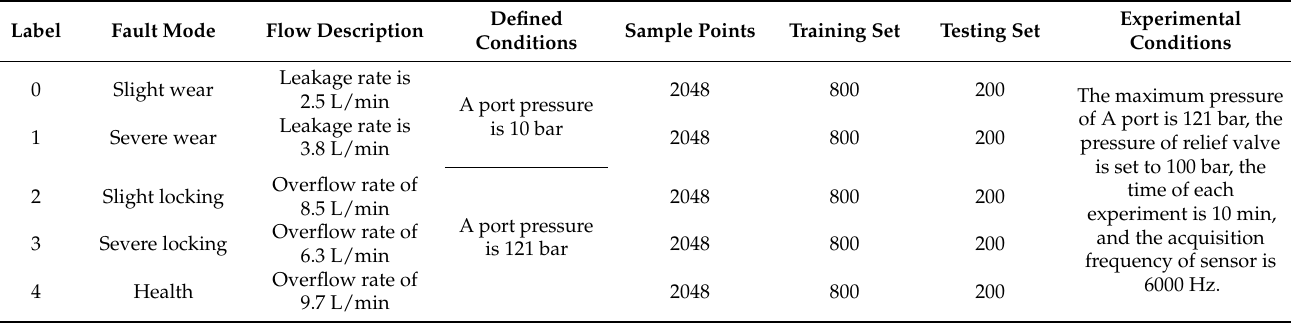
Table 1. Fault description of the waterproof